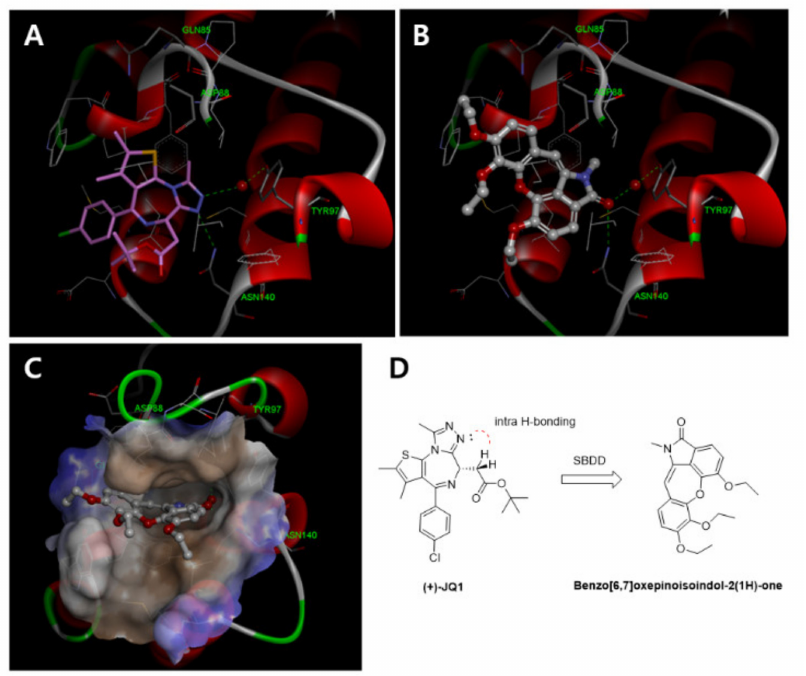
Figure 2. Binding pocket of Brd4 bromodomain and ligand structure-based drug design (SBDD). ( A ) Crystal structure of the bromodomain of human Brd4 in complex with the inhibitor JQ-1(PDB code: 3MXF, human 1.6 Å). ( B ) Molecular docking of designed compound of aristoyanine with Brd4 bromodomain binding pocket. ( C ) Designed docking model with Gaussian surface. ( D ) Novel compound benzo[6,7]oxepinoisoindol-2(1 H )one scaffold derived from